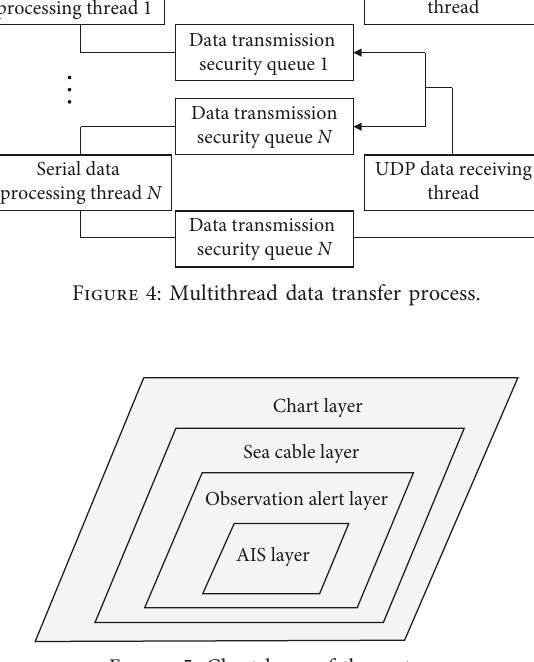
Figure 5: Chart layer of the